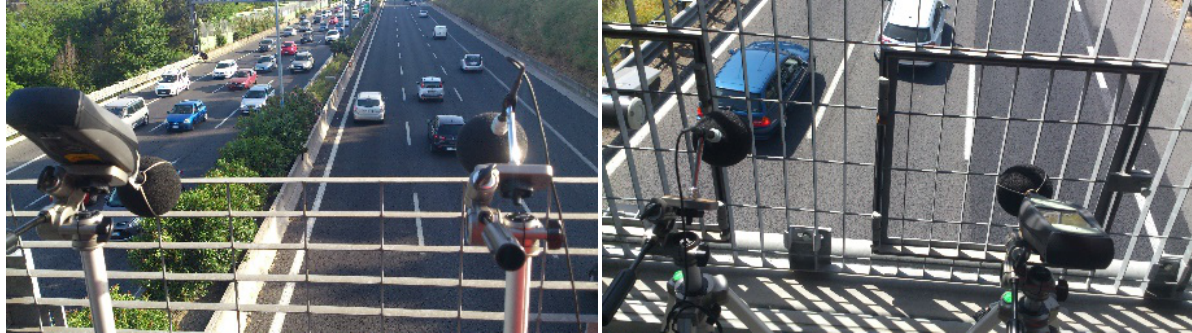
Figure 10: Examples of the recording devices installed in the ANAS S.p.A. portals situated on the A90 highway surrounding Rome